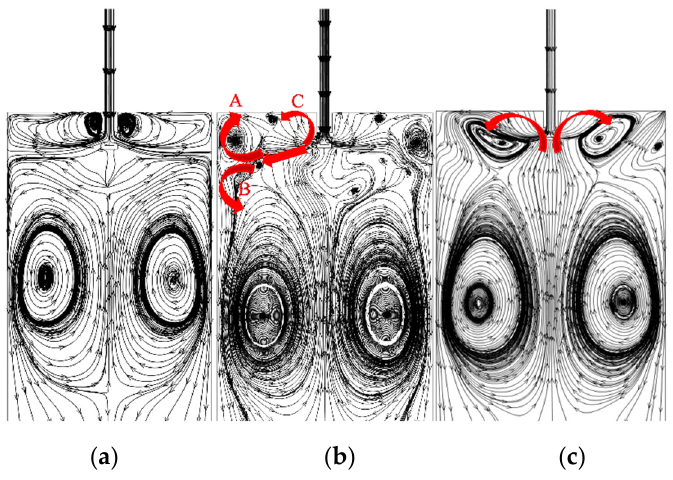
Figure 9. Streamlines on the center longitudinal section of the mold with different widths under high fixed steel throughput: ( a ) 1600 mm, ( b ) 1800 mm, and ( c ) 2000 mm.